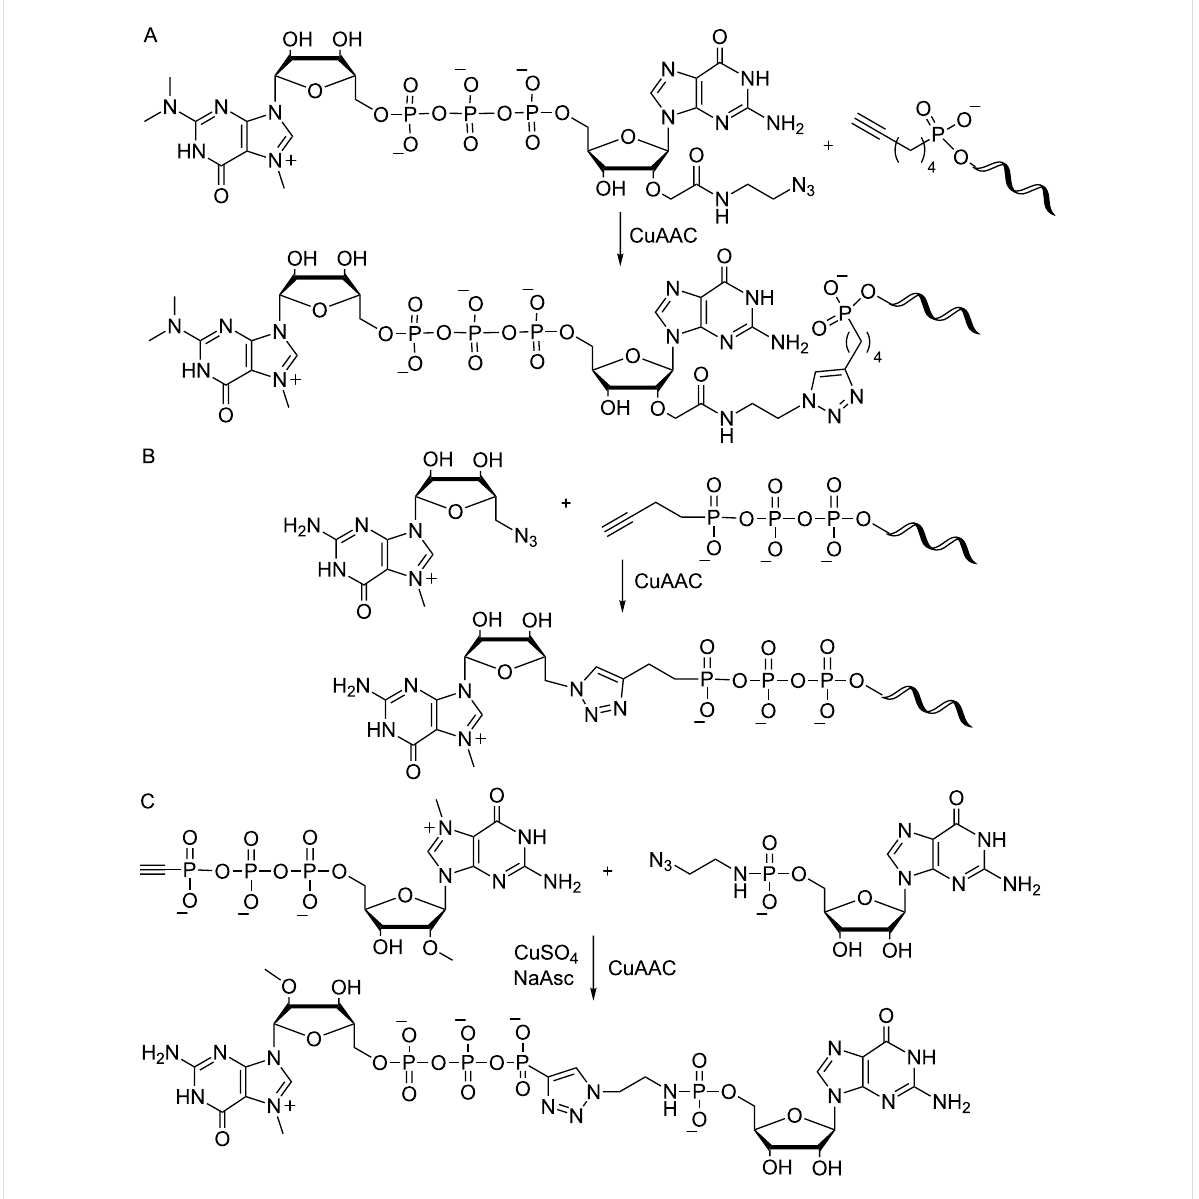
Figure 7: Click chemistry for the preparation of capped RNA and cap analogues. (A) Preparation of capped RNA via a copper-catalyzed azide–alkyne cycloaddition (CuAAC) of an azido-modified cap analogue with a 5'-alkyne bearing RNA [120]. (B) An alkyne-modified triphosphorylated RNA is reacted with 5'-azido-methylguanosine in a CuAAC [121]. (C) Alkyne- and azido-containing nucleotide building blocks are reacted in a CuAAC to give a functional cap analogue